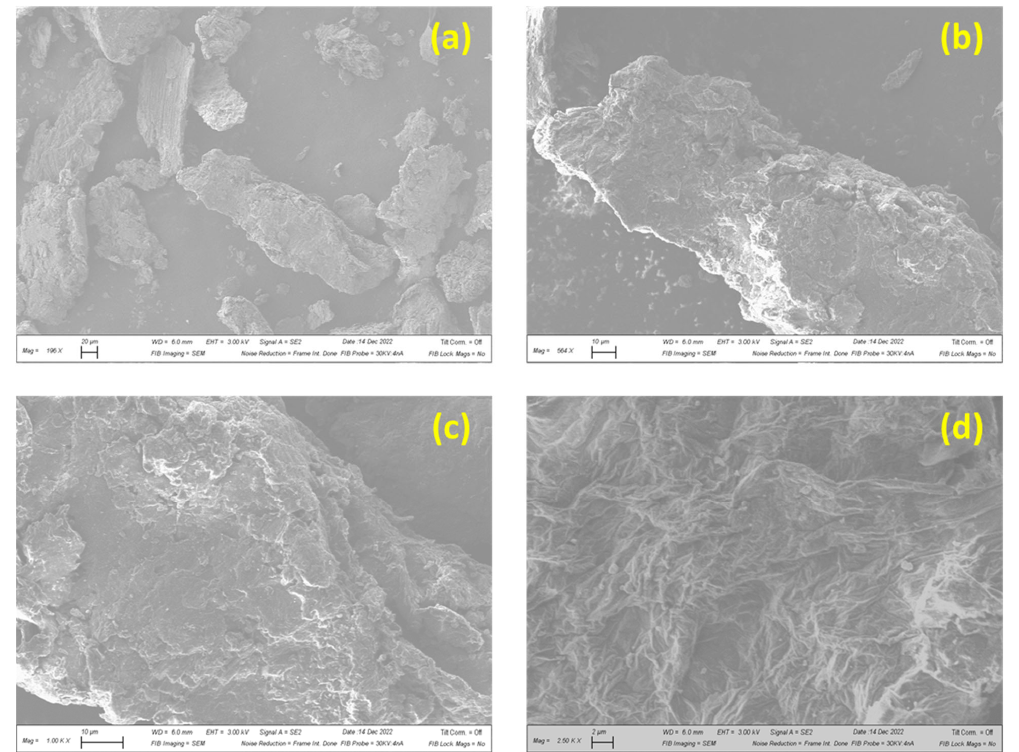
Figure 3. XRD pattern of the graphite powder starting reactant ( bottom ) and graphene oxide final product ( top ).